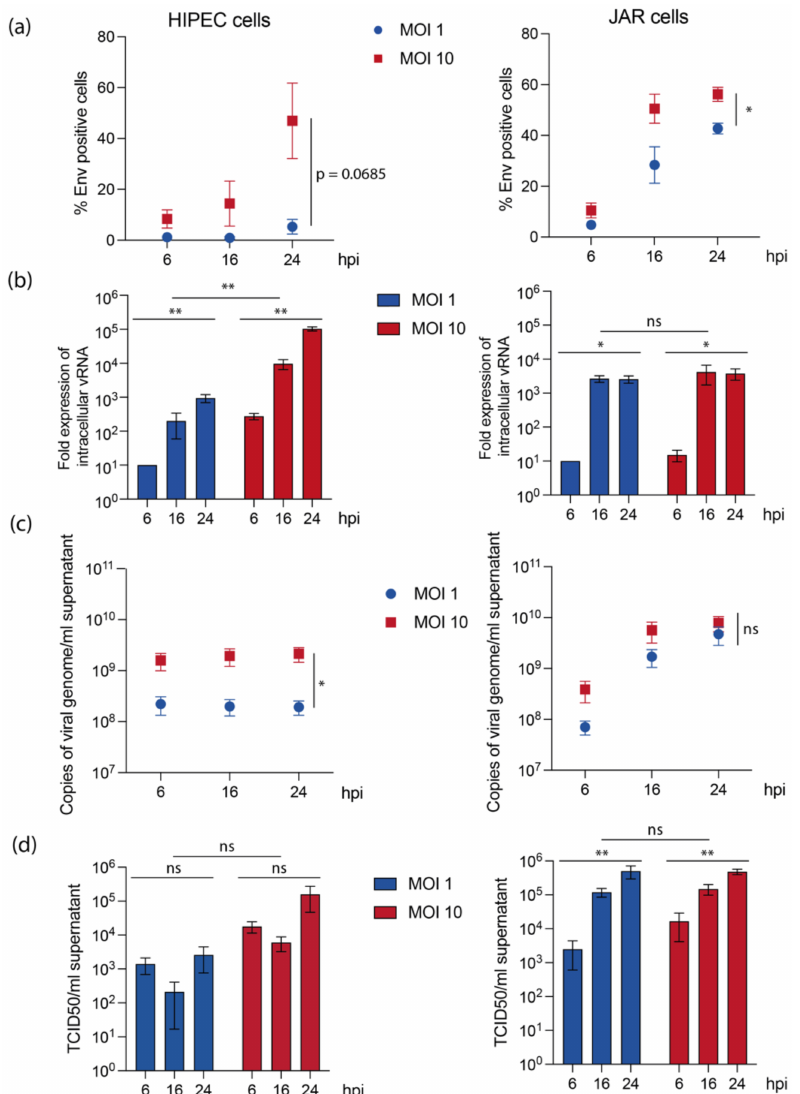
Figure 2. JAR cells and HIPEC allow USUV productive replication cycle with different efficiencies. HIPECs (left column) or JAR cells (right column) have been infected by USUV at MOI 1 or 10 dur- ing indicated times (hpi: hours post-infection) before proceeding to analyses. ( a ) Quantification of the proportion of infected cells determined by flow cytometry, via intracellular staining of Env antigen. Symbols represent the mean ± SEM for three independent experiments for HIPECs and four independent experiments for JAR cells. ( b ) Quantification of viral RNA extracted from infected cells, upon normalization by actin mRNA and by the level of viral RNA at 6 hpi for MOI 1. His- tograms represent mean ± SEM for three independent experiments. ( c ) Quantification of viral RNA released in cell supernatant. Symbols represent the mean ± SEM for five independent experiments. ( d ) Quantification of infectious particles released in cell supernatant. Histograms represent mean ± SEM for five independent experiments. In ( a – d ), a two-way ANOVA statistical test was performed to evaluate a statistical difference between cell lines and MOI (ns, non-significant; *, p < 0.05; **, p <